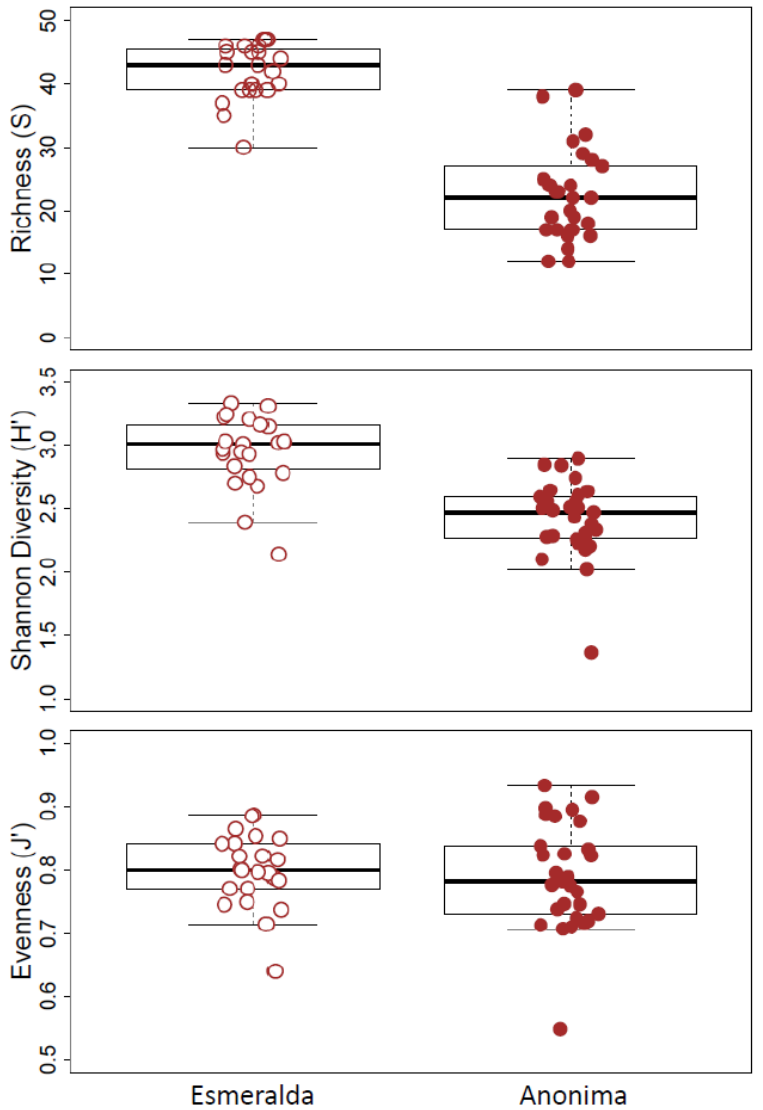
Figure 3. Boxplots of species richness (S), Shannon diversity (H’), and evenness (J’) calculated for Lake Esmeralda (Cape Lamb) and Lake Anónima (Devil’s Bay) sediment core samples. Box bottoms and tops represent first and third quartiles, and the thick black lines represent median values.